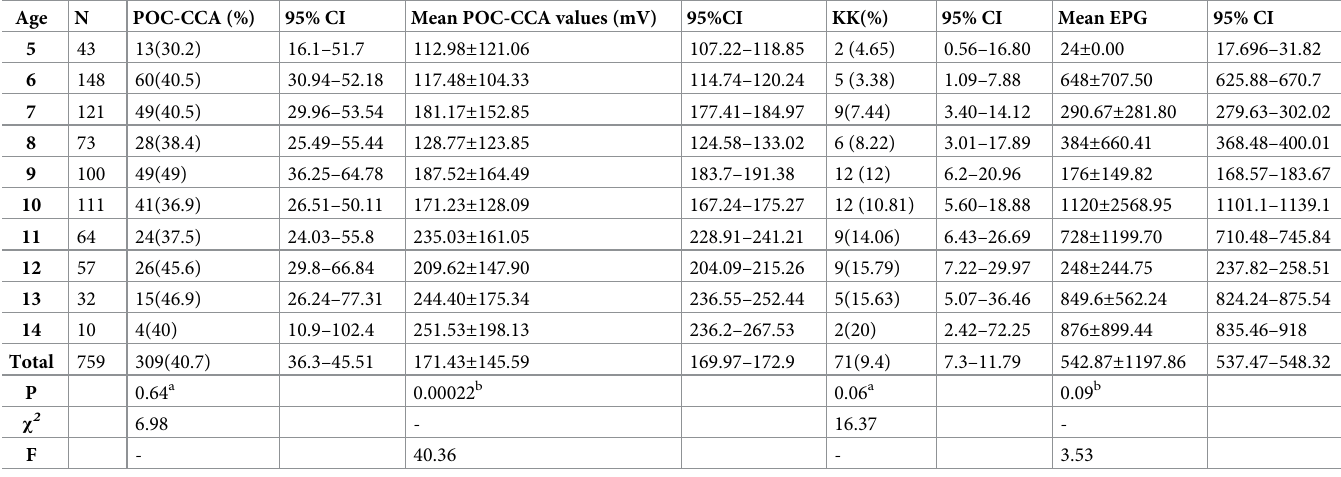
Table 3. Prevalence and intensity of S . mansoni infections by KK and POC-CCA according to